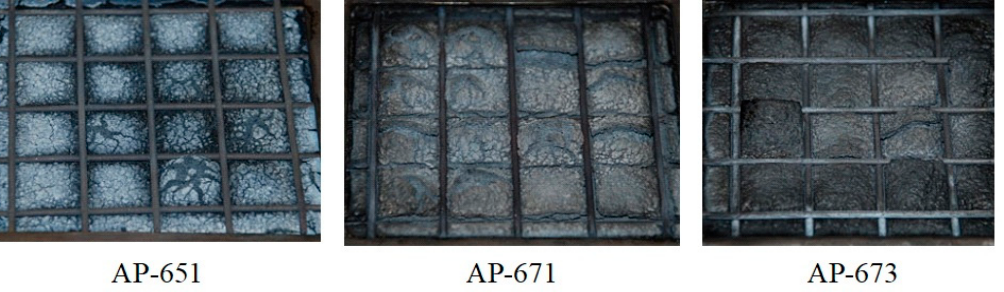
Figure 6. Photographs of the residua after cone calorimeter test of AP ‐ 651, AP ‐ 671 and AP ‐ 673.